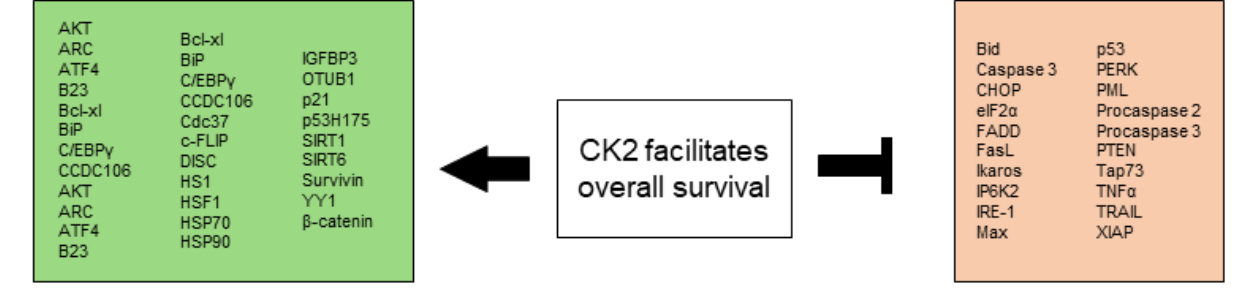
Figure 2. CK2-dependent modified proteins that facilitate overall survival. Proteins that are acti- vated in this process by CK2 modification are shown on the left (highlighted in green), and proteins that are restricted in their function are shown on the right (highlighted in red).